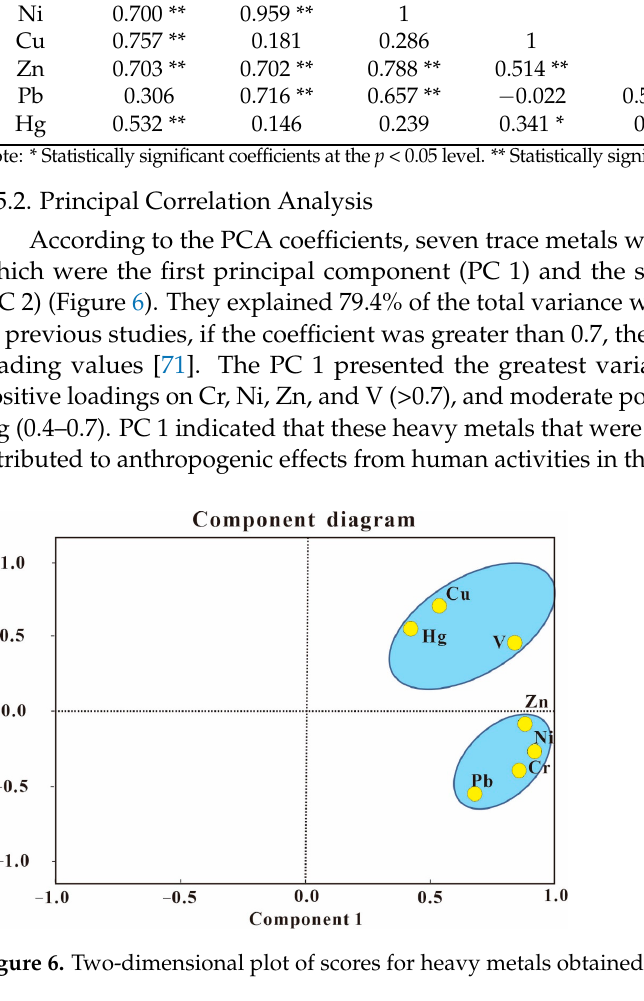
Table 9. Pearson correlation coefficients for the soil metals.